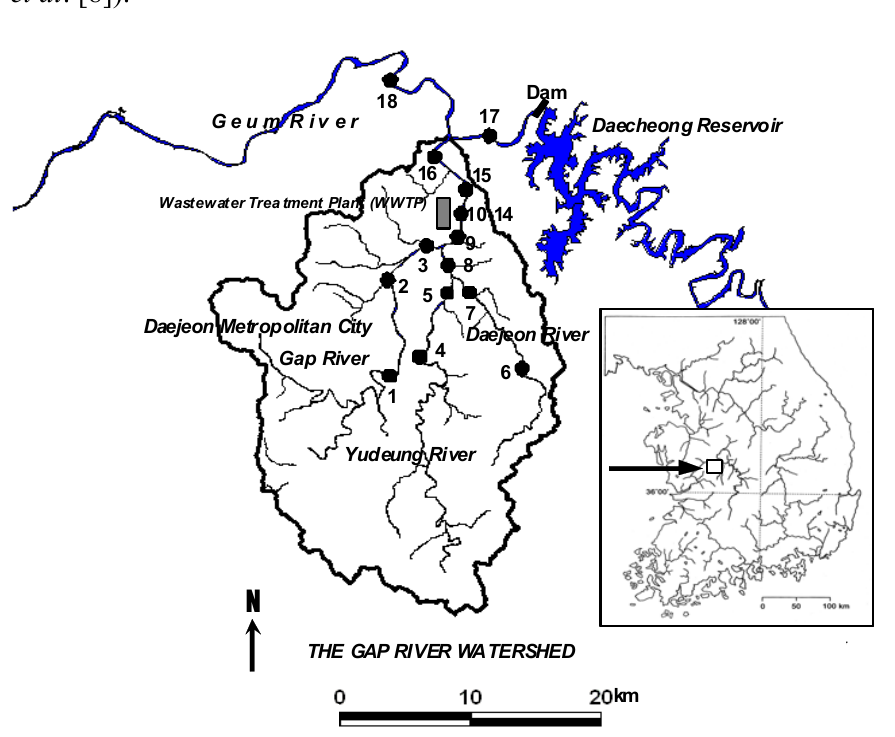
Figure 1. The Gap River watershed. Filled circles indicate sampling locations (adopted from Hur et al .